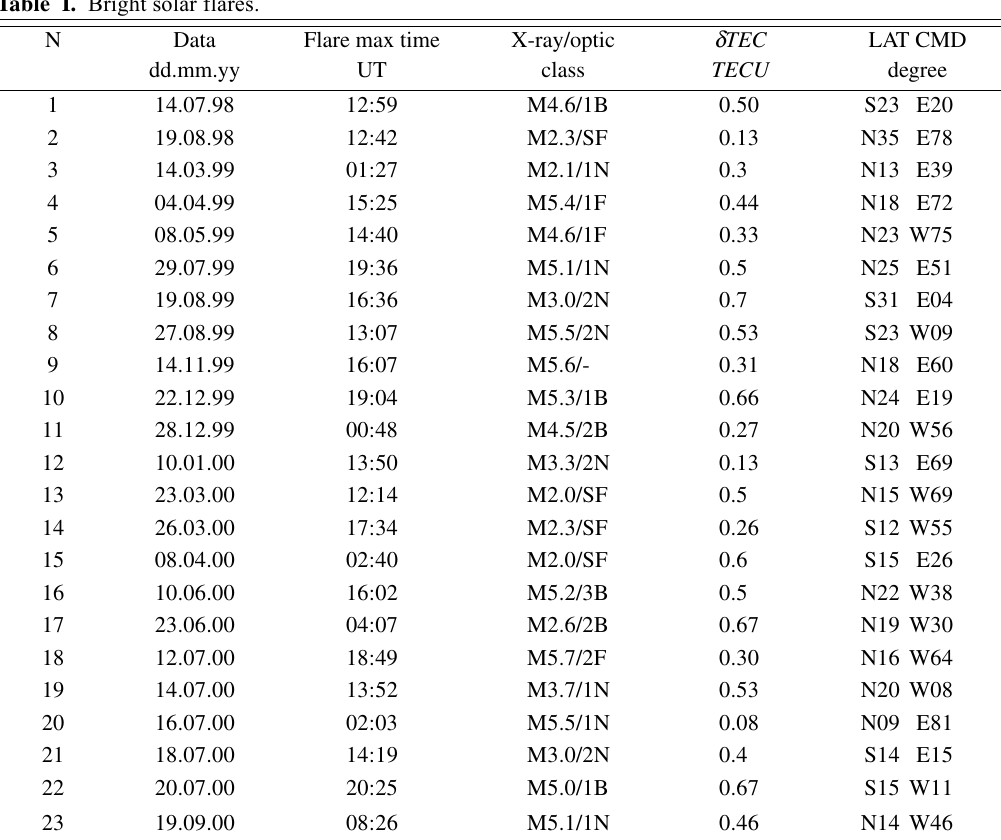
Table I. Bright solar